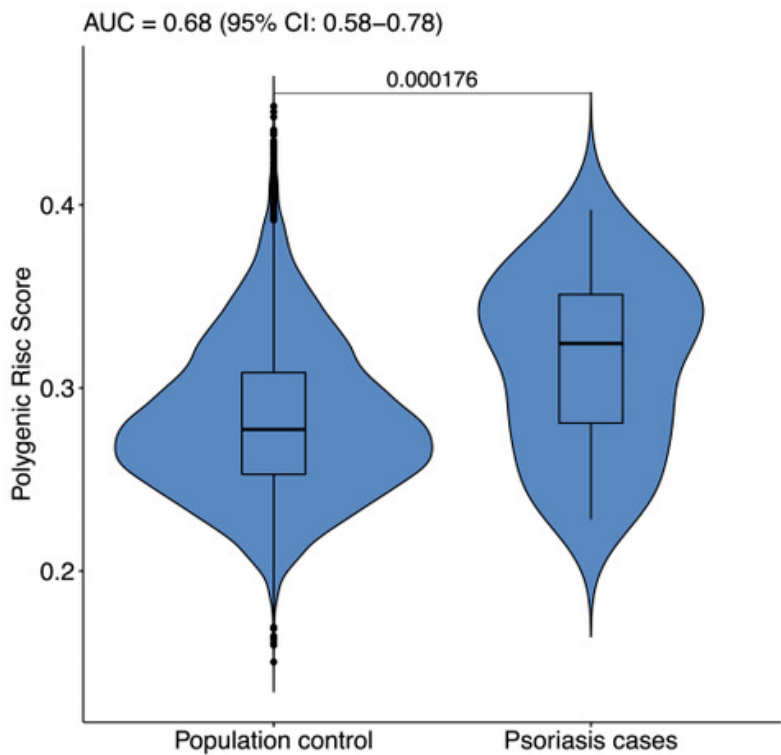
Figure 2. 38 SNP genetic risk score (GRS) [15] distribution violin plots for the general Russian population sample (Genotek clients; sample size = 15,776) vs. moderate-to-severe and severe psoriasis patients. The area under curve (AUC) value for the GRS was 0.6821 (95% CI: 0.5816–0.7837). Mann–Whitney–Wilcoxon p -value indicated above the line.